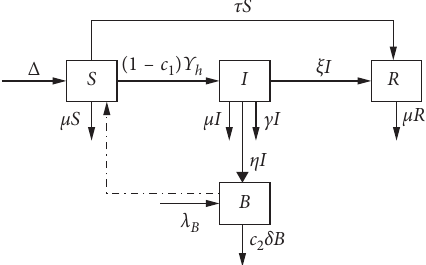
Figure 1: The transmission dynamics of Table 1: Description of parameters involved in the flow chart diagram.